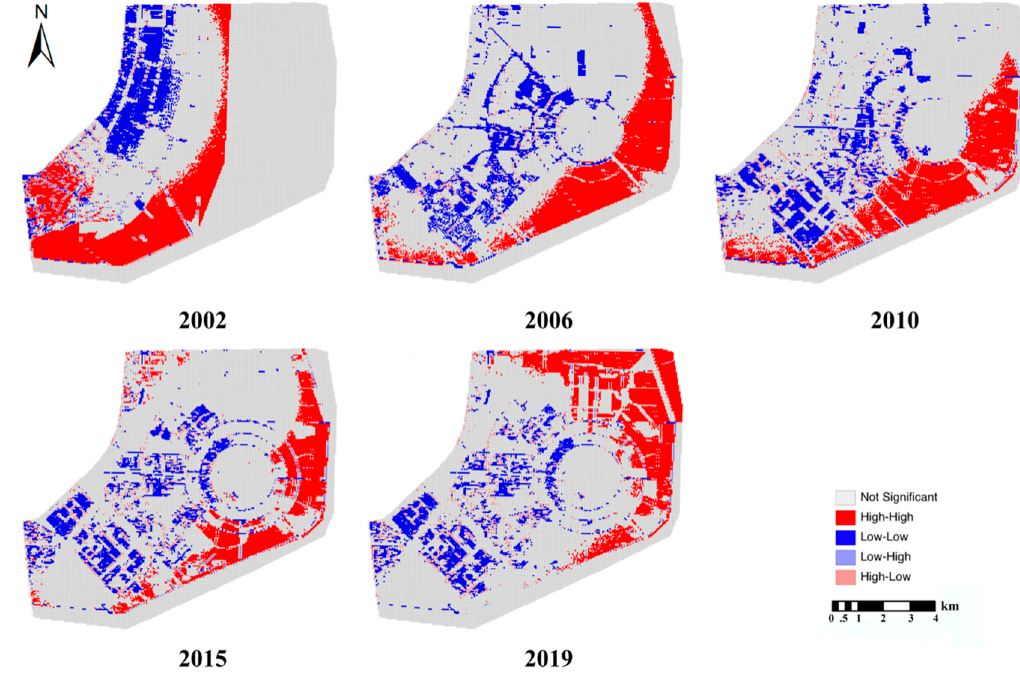
Figure 3. Local indicators of spatial association (LISA) cluster maps of habitat quality.